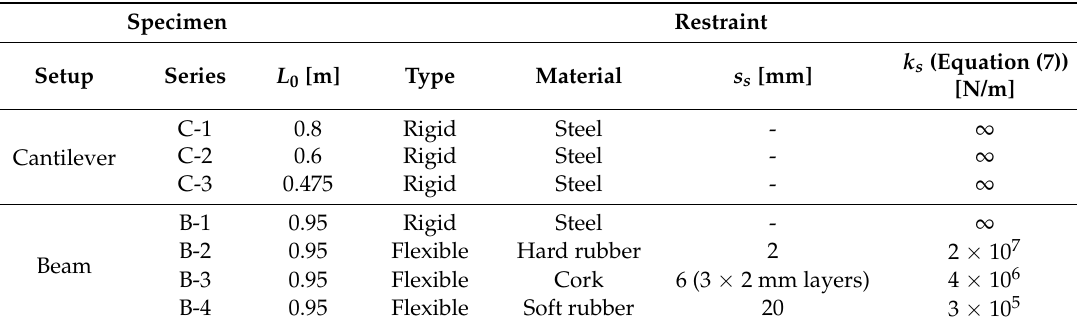
Table 1. Cantilever and beam tested